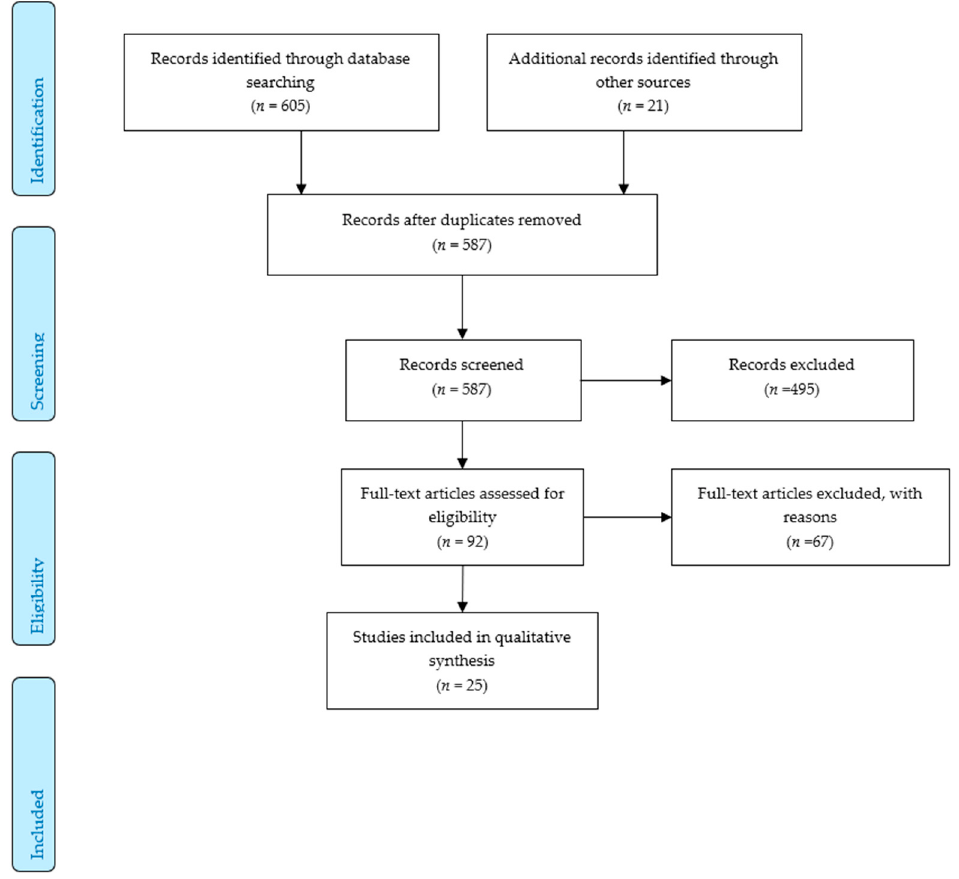
Figure 1. Flow chart.